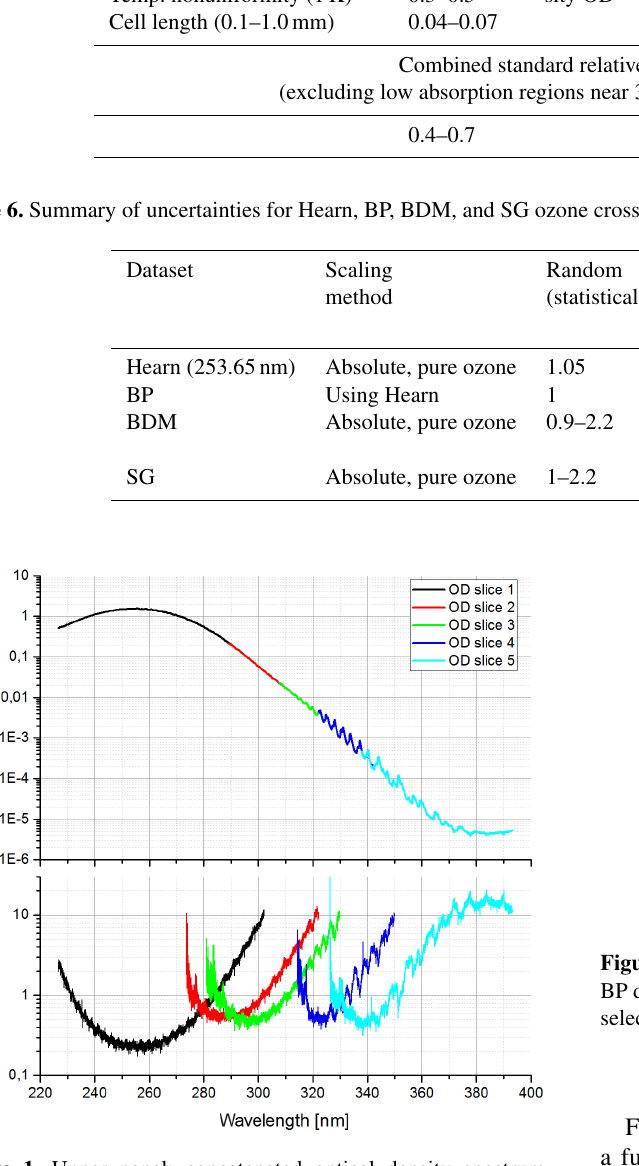
Figure 1. Upper panel: concatenated optical density spectrum. Lower panel: relative uncertainty of various OD spectra used for concatenation. Instruments: Echelle/Fourier transform spectrome- ter (FTS); number of averaged spectra: 2000 (Echelle)/100 (FTS); acquisition time: ∼ 30min; light sources: Xe and D 2 lamps. From Serdyuchenko et al. (2014).